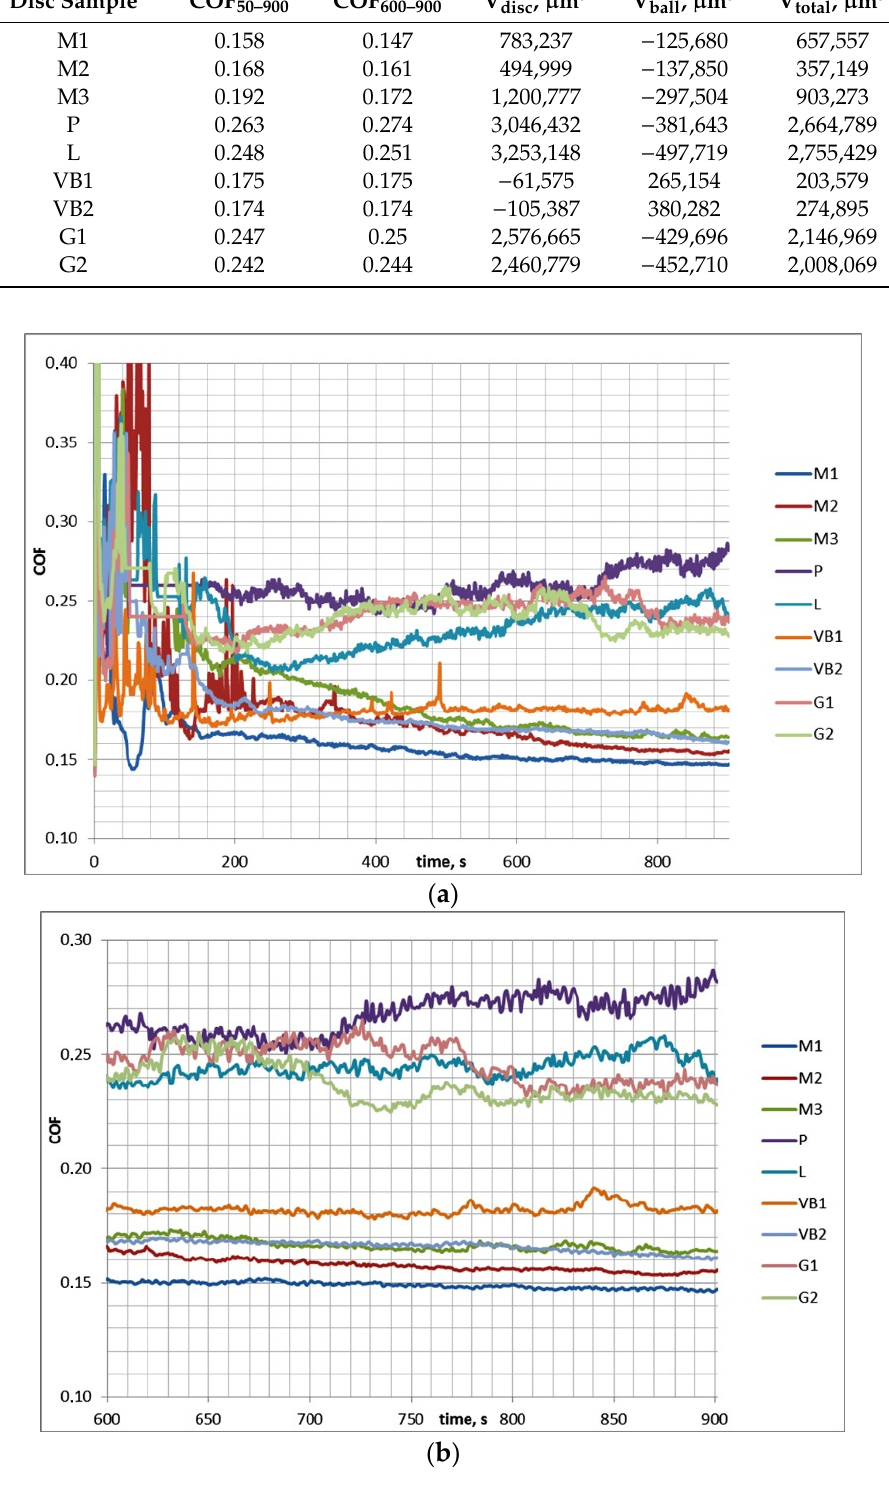
Figure 5. Friction coefficients for whole test B ( a ) and for its last 5 min ( b ).